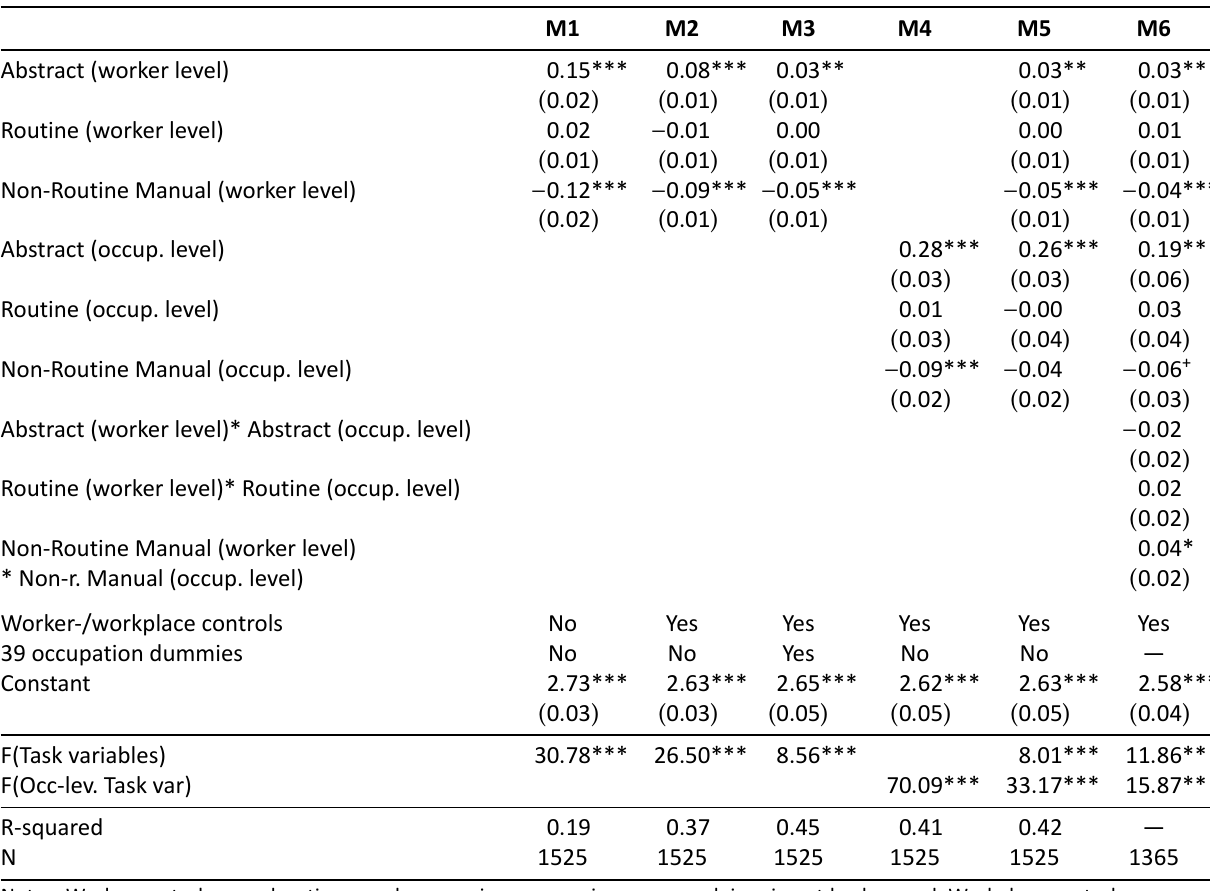
Table A2. OLS and Hausman-Taylor regressions of Log Hourly Wages on Task Scales for occupations with n BIBB/BAuA Employment Survey 2012 and Suppl. Task Survey to the Employment Survey